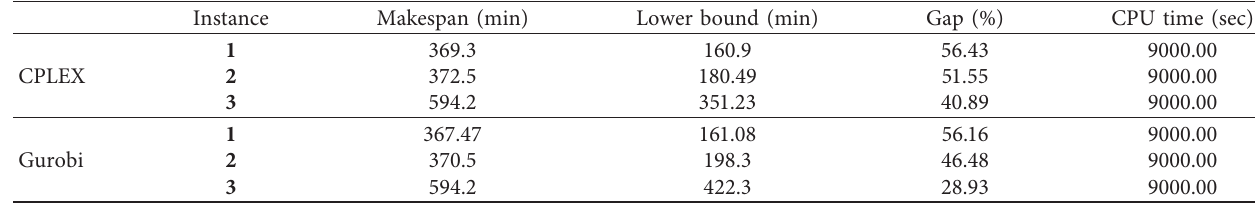
Table 3: Obtained results for the current C shift.